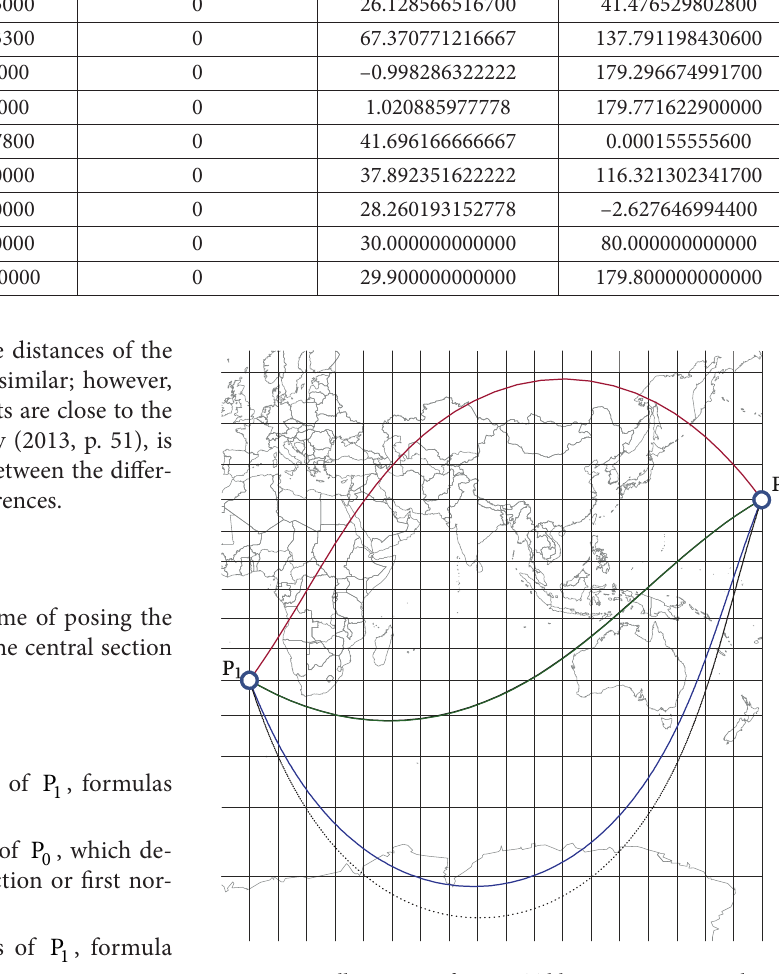
Figure 7. Illustration of case 9, Table 3, in a Mercator chart (GRS80 ellipsoid). From South to North: geodesic line (dotted line), first normal section (in blue), mean (in green) and central section (in black; both paths are confused in the chart) and second normal section (in